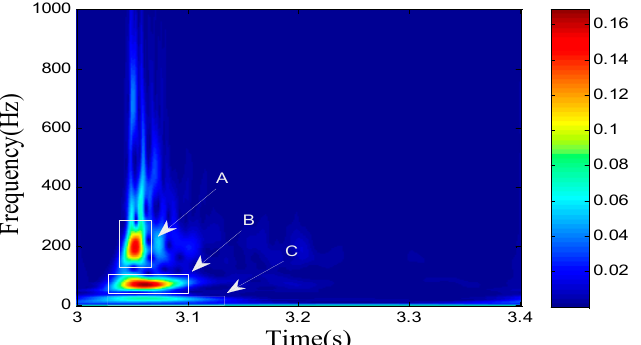
Figure 4. Time–frequency diagram of the node group (A is the P-wave region, B is the S-wave region, and C is the surface wave